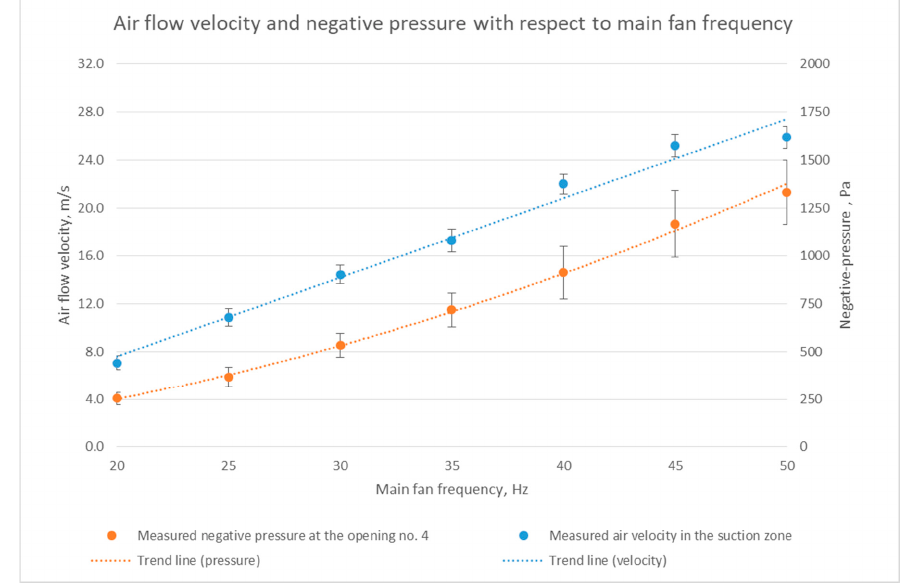
Figure 7. Air flow velocity in the suction zone and vacuum value at the separator outlet as functions of the main fan operating frequency.